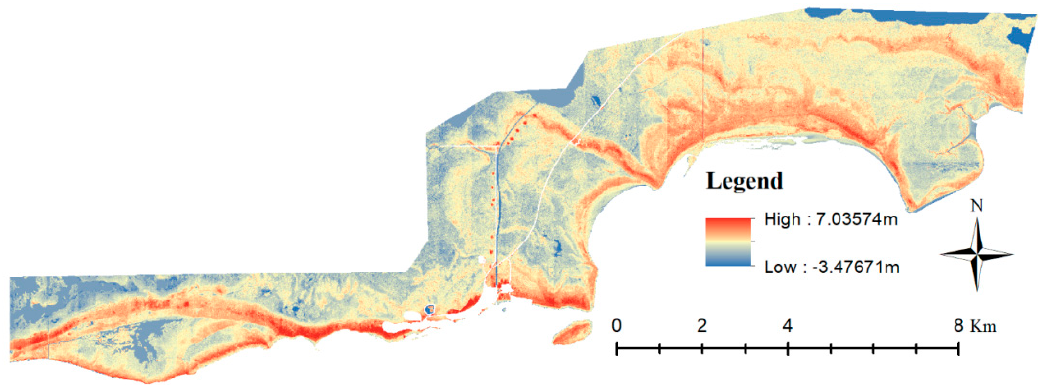
Figure 3. Digital Terrain Model (DTM) of the 71 km 2 study site, Flamingo, Everglades National Park. Areas with highest elevations are red; areas with lowest elevations are dark blue. The higher elevation buttonwood embankment is seen as the highest elevation natural area throughout the study site. The circles of high elevation along the Buttonwood Canal (center of image) are likely spoil piles from when the canal was built. The roads and campgrounds are white. The DTM was created with LiDAR data flown by the Florida Division of Emergency Management in 2007–2008.